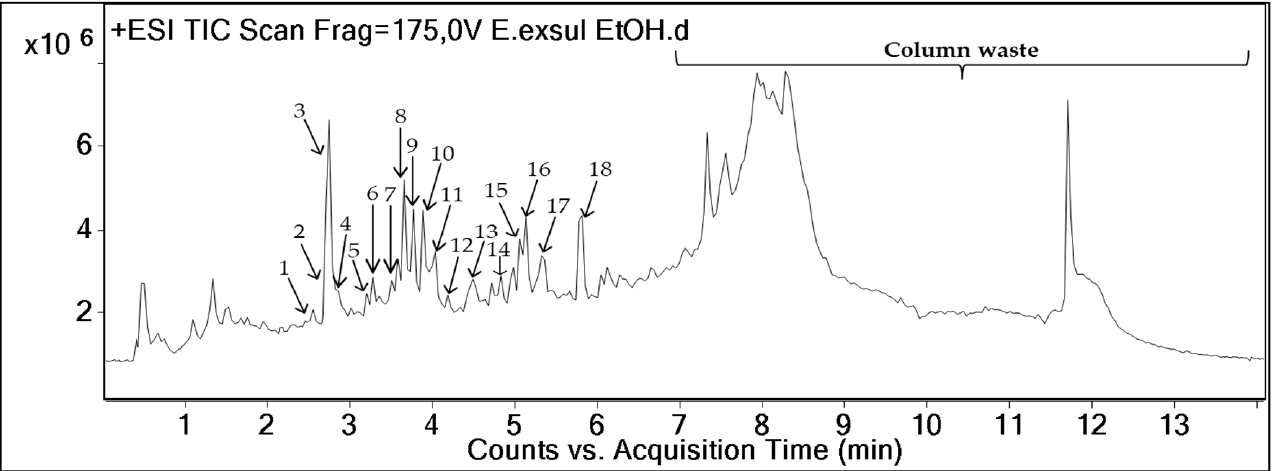
Figure 1. Total ion chromatogram (TIC) in positive ion mode of the ethanolic extract of Erismadelphus exsul obtained on an Agilent 6530 Q/ToF (Scan rang m/z 100–1700). The number above each peak corresponds to the peak numbers in Table 1.